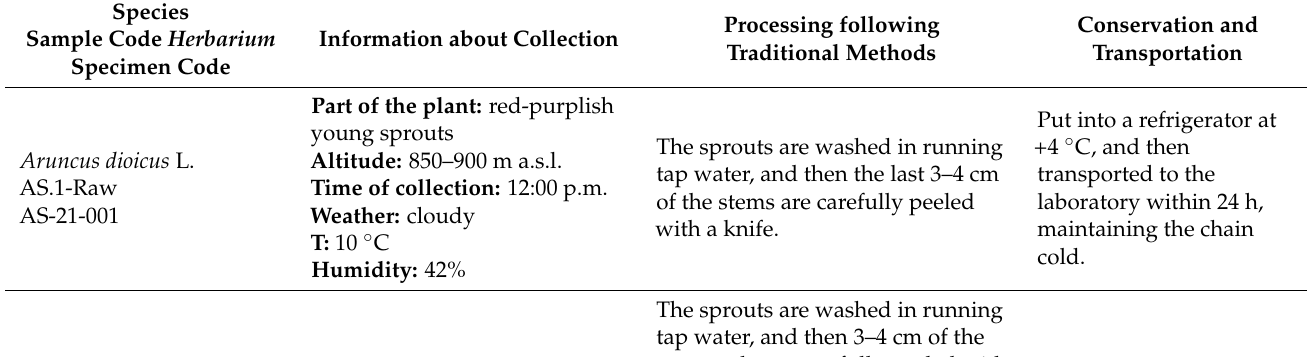
Table 1. Collection, processing, and transportation steps for raw and cooked samples of the six